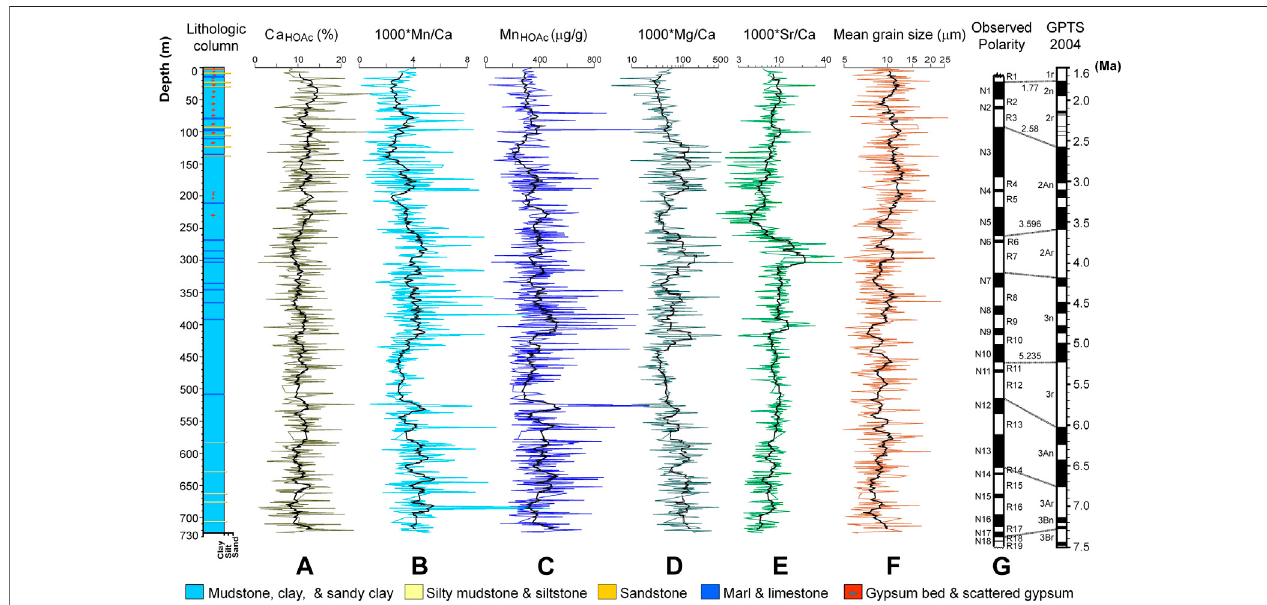
FIGURE4| Depthpro fi lesofMn,Ca,Mg,andSrvariationsofaceticacidleachate(HOAc)intheSG-1bcore. (A) CaconcentrationsintheHOAcleachate(Ca HOAc ); (B) The ratio of 1000*Mn/Ca in the HOAc leachate; (C) Mn concentrations in the HOAc leachate (Mn HOAc ); (D) The ratio of Mg/Ca in the HOAc leachate; (E) The ratio of 1000*Sr/Ca in the HOAc leachate; (F) Mean grain size from Lu et al. (2015); (G) Observed magnetic polarity sequence of the SG-1b core and its correlation with the GeomagneticPolarityTimeScale(GPTS,Gradsteinetal.,2004)(Zhangetal.,2014a).Thelithologycolumnissimpli fi edaccordingtoZhangetal.(2014b).Thinlines indicate the raw data for (A – F) . Bold solid lines in the records provide 13-point running averages for (A – F) .